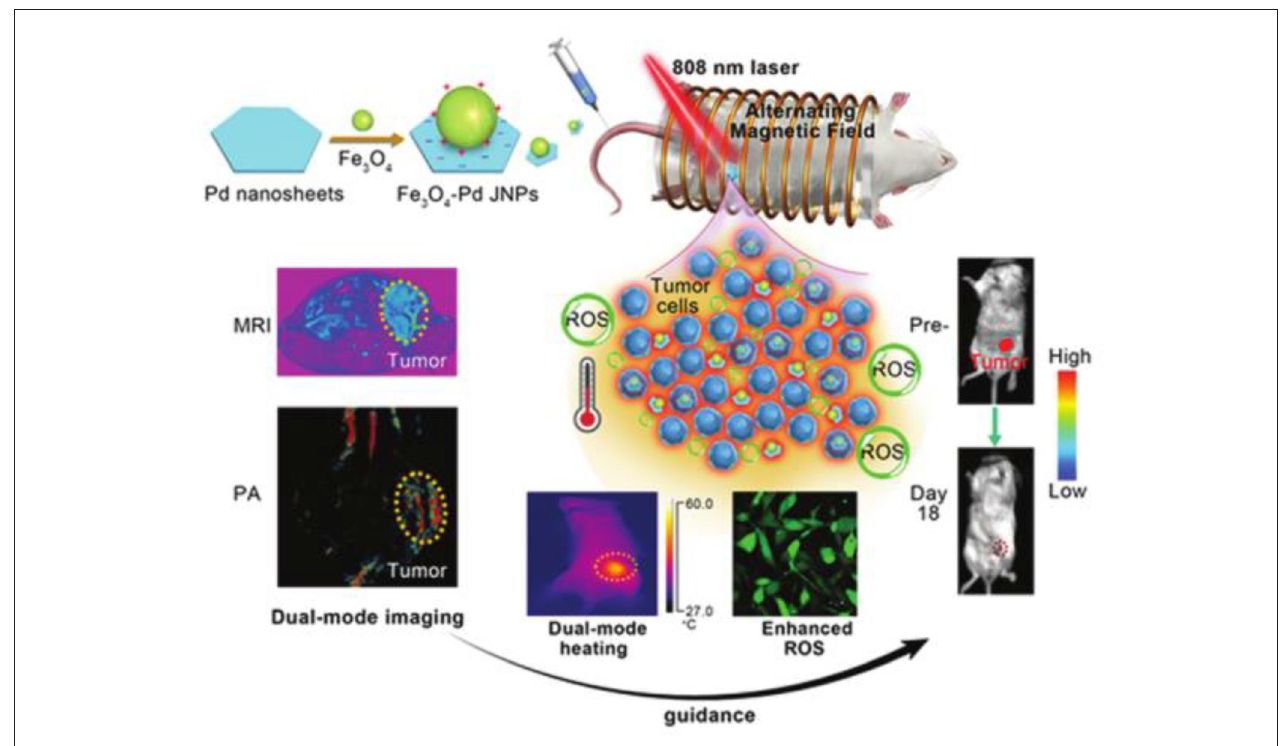
FIGURE 10 | A schematic illustration for Fe 3 O 4 -Pd JNPs enhanced ROS-mediated antineoplastic therapy. Reproduced, with permission, from Ma et al. (2019). Copyright 2019, Royal Society of Chemistry.